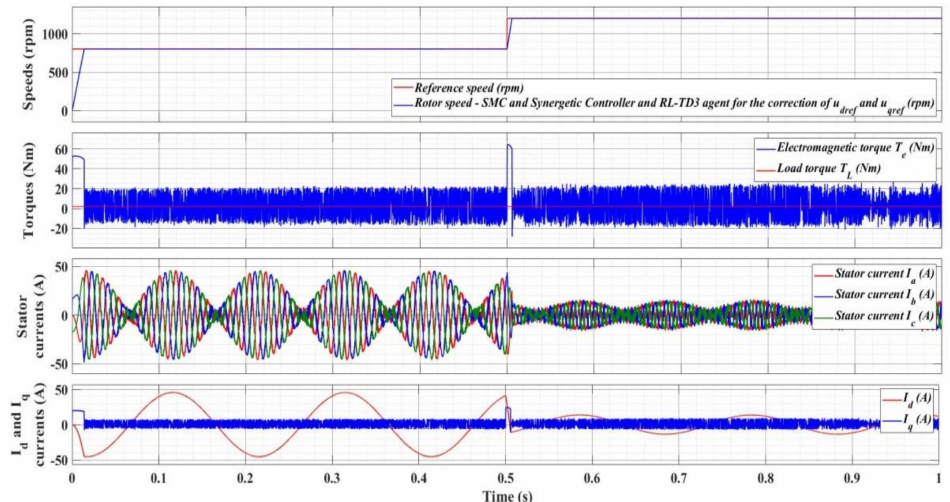
Figure 38. Time evolution for the numerical simulation of the PMSM control system based on control using SMC and synergetic controllers using an RL-TD3 agent for the correction of u dref and u qref : T L = 2 Nm with 0.2 Nm magnitude of uniformly distributed noise and 50% increase in J